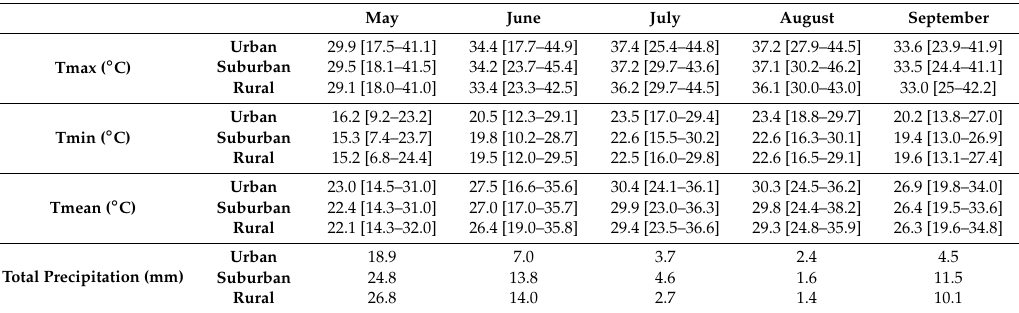
Table 2. Average monthly maximum (Tmax), minimum (Tmin), and mean (Tmean) air temperatures (and daily absolute maximum and minimum ambient air temperatures) and total precipitation using data from years 1988–2017 for urban, suburban, and rural